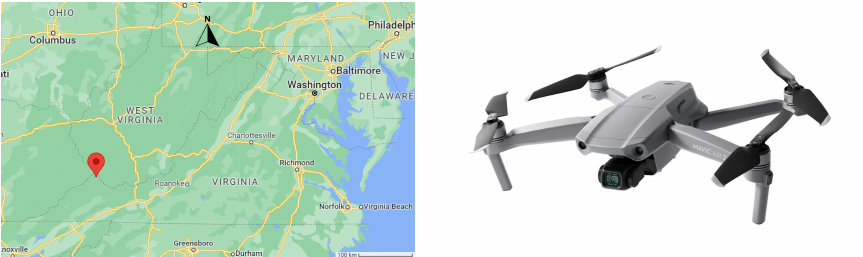
Figure 1. A map with a pin marking the location of Hurley, VA is shown on the left. The right portion shows a DJI Mavic Air 2 drone [19], which was used to capture imagery at the test area in Hurley. For flood analysis of the test area, weather data was needed from the flood event on 30 August 2021 along with terrain data from before the flood event. Terrain data for this area was acquired from the Virginia LiDAR Inventory Web Mapping Application [20]. This portal for open data includes LiDAR point clouds and Digital Elevation Models obtained from NOAA (National Oceanic and Atmospheric Administration), USGS (United States Geological Survey), and VGIN (Virginia Geographic Information Network) data portals. For our flood analysis, the Digital Elevation Models were used. These were last updated in 2016, which was five years before the flood event. As a result, we are assuming the terrain along the road did not significantly change between when the DEMs were produced and the flood in 2021. A portion of one of these sections of the Digital Elevation Model is shown in Figure 2.